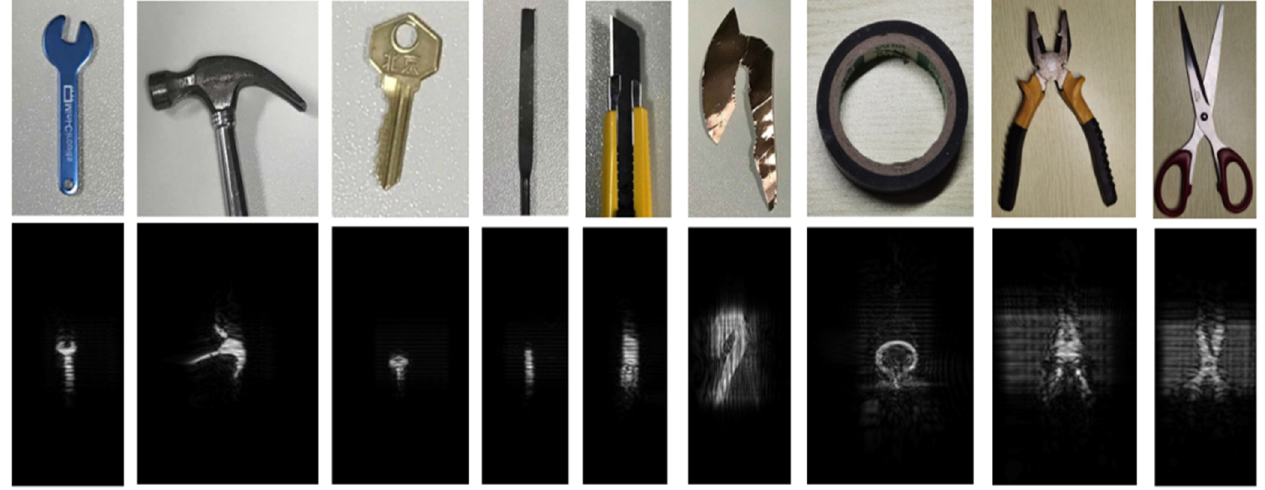
Figure 8. Part of the original data sets and the corresponding SAR radar images.